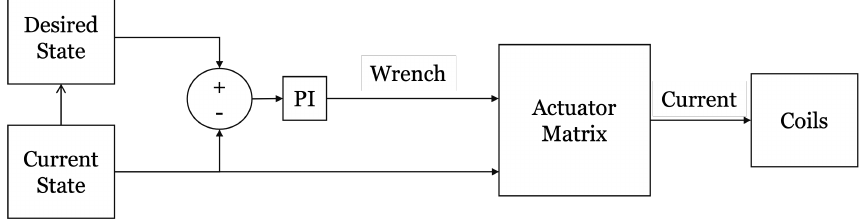
Figure 20. The actuation logic.